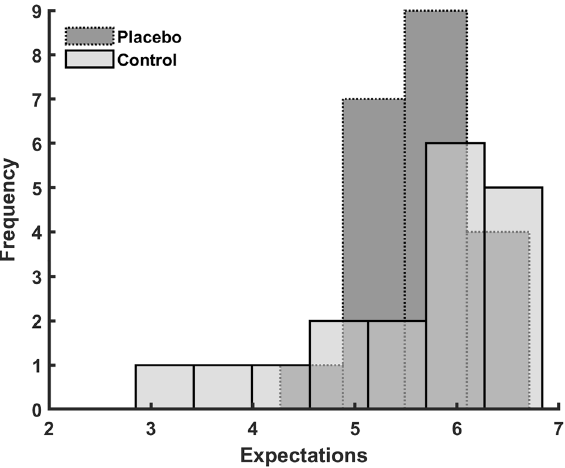
Figure 3. Frequency distribution of the expectations for the placebo vs control